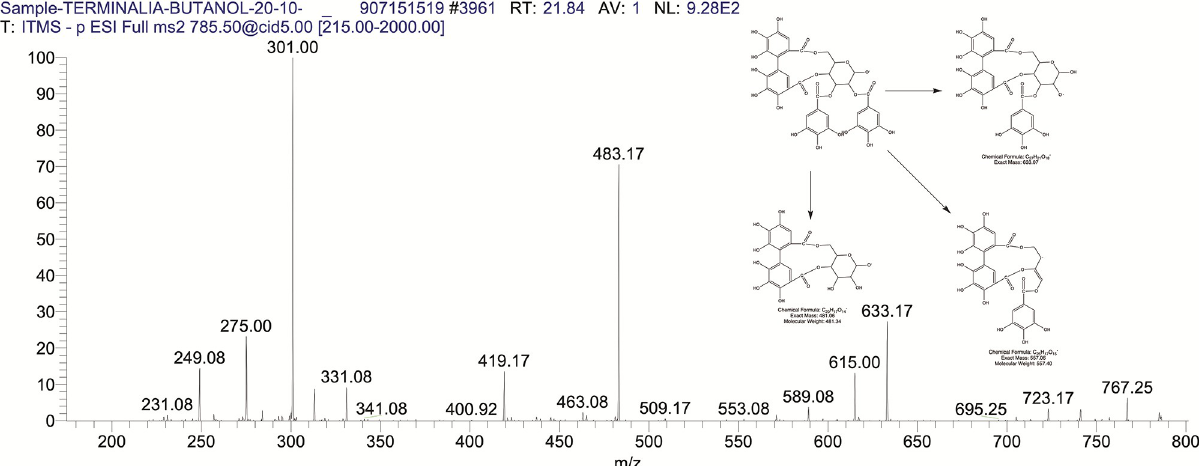
Fig 6. The mass spectrum of tellimagrandin, pedunculaginII, (Digalloyl HHDP-hex) and its fragmentation pattern.